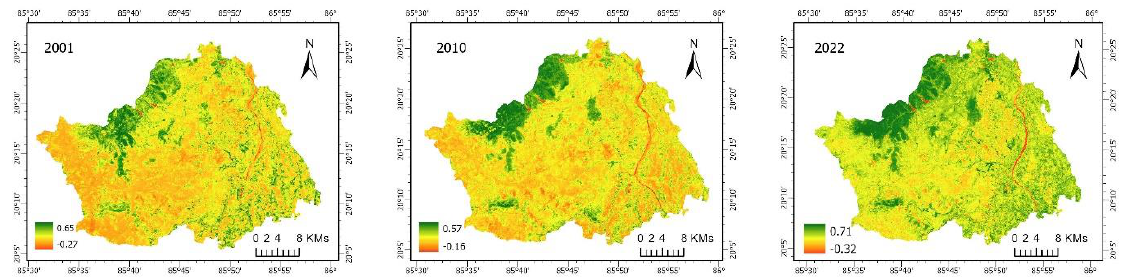
Figure 4. NDVI Spatial distribution from 2001 to 2020